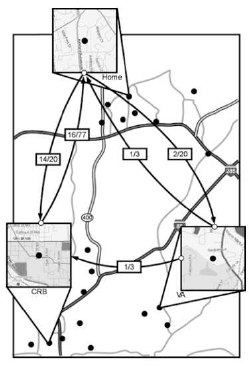
Fig. 6 Examples of different location state transitions in a Markov model [51] .